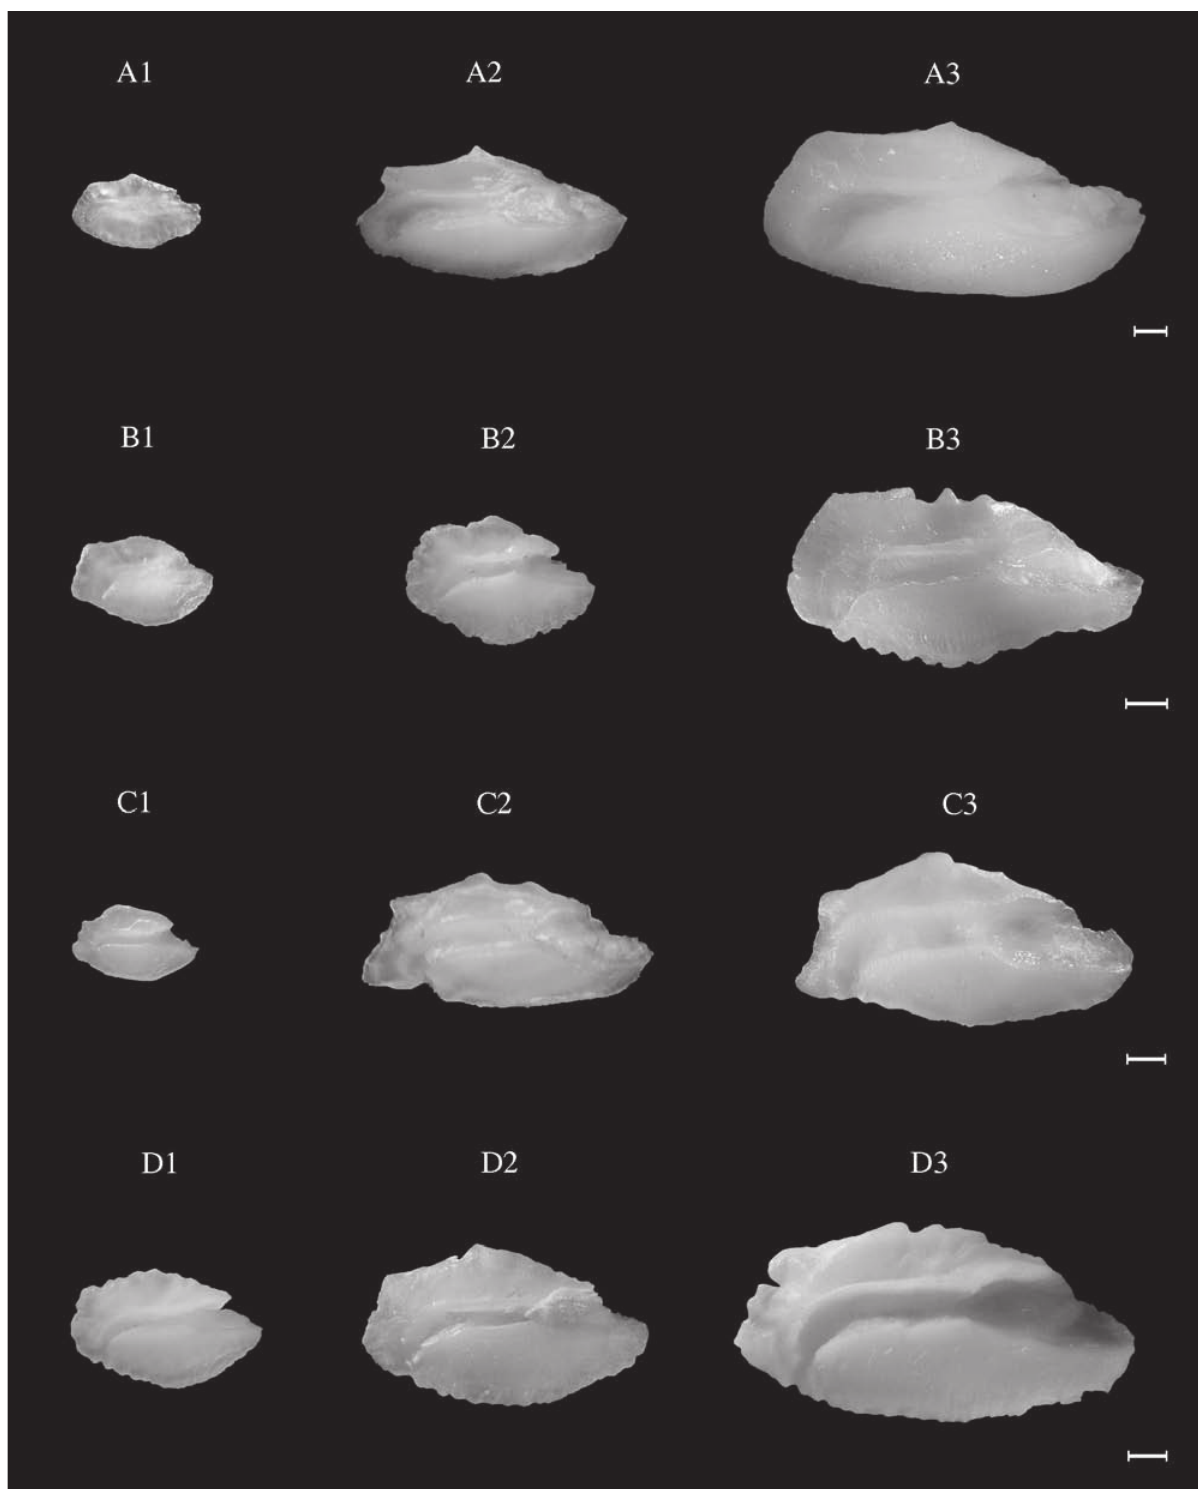
Fig. 59. – Diplodus sargus . TL: A1, 9.9 cm (NEA); A2, 28.0 cm (WM); A3, 40.0 cm (CEA). Diplodus vulgaris . TL: B1, 8.5 cm (WM); B2, 15.0 cm (CEA); B3, 25.5 cm (NEA). Lithognathus mormyrus . TL: C1, 7.0 cm (CEA); C2, 24.0 cm (WM); C3, 32.9 cm (NEA). Oblada melanura (CEA) . TL: D1, 10.5 cm; D2, 20.0 cm; D3, 34.0 cm. Scale bar = 1